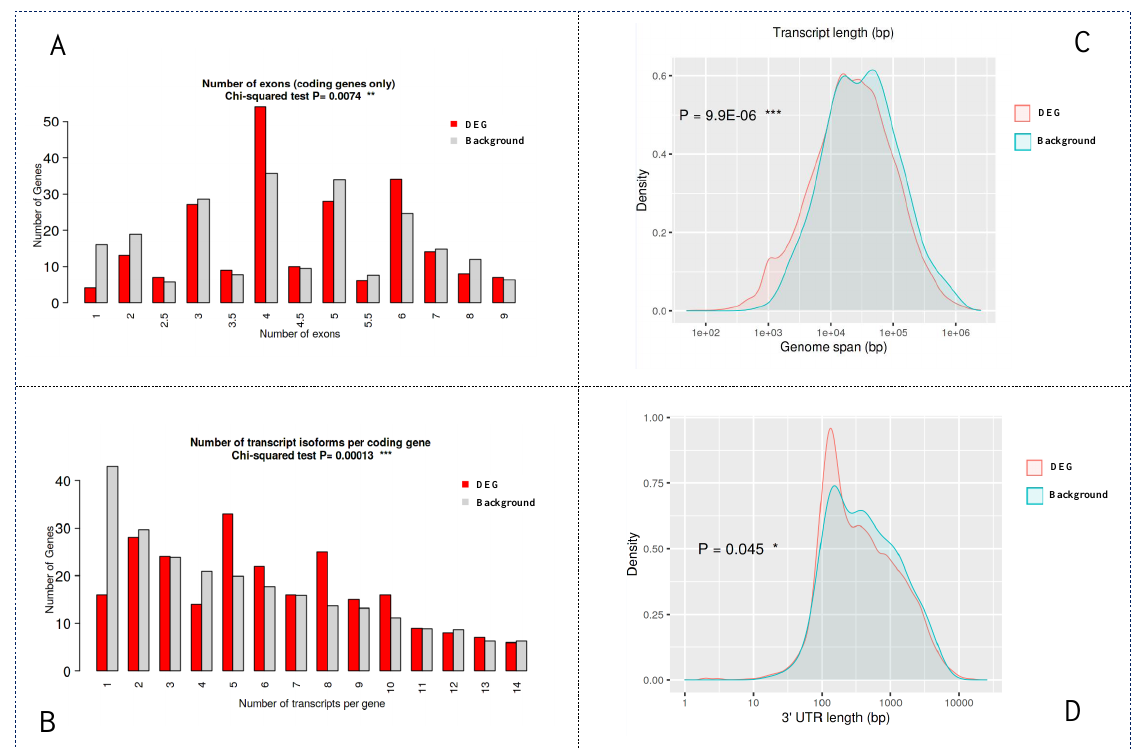
Figure 2. Genomic specificity analysis compared with the whole genome by ShinyGO. ( A ) Number of exons by chi-squared test; ( B ) Number of transcript isoforms per coding gene chi-squared test. ( C ) Transcript length compared with the whole genome; ( D ) 3 (cid:48) -UTR length compared with the whole genome. The symbol “*” indicated the significance level of the comparison.